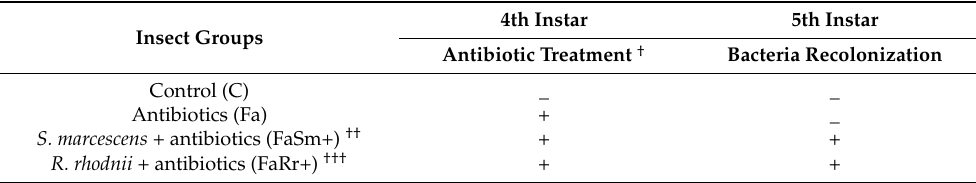
Table 1. The protocol designed to treat the different groups of Rhodnius prolixus nymphs. Insect